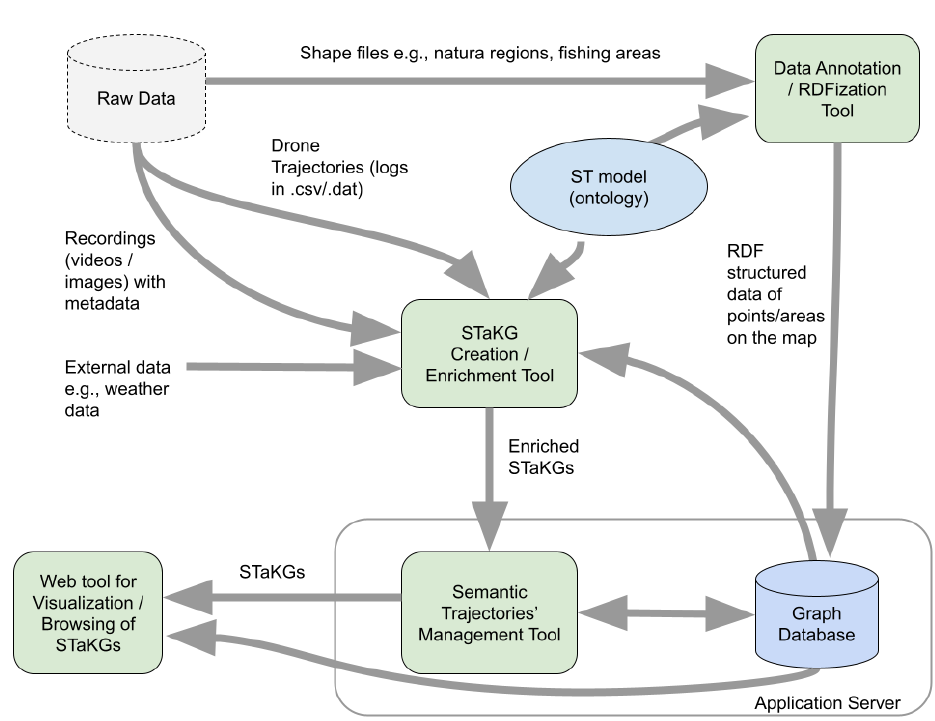
Figure 6. High-level architecture and data exchange of STaKG toolset.